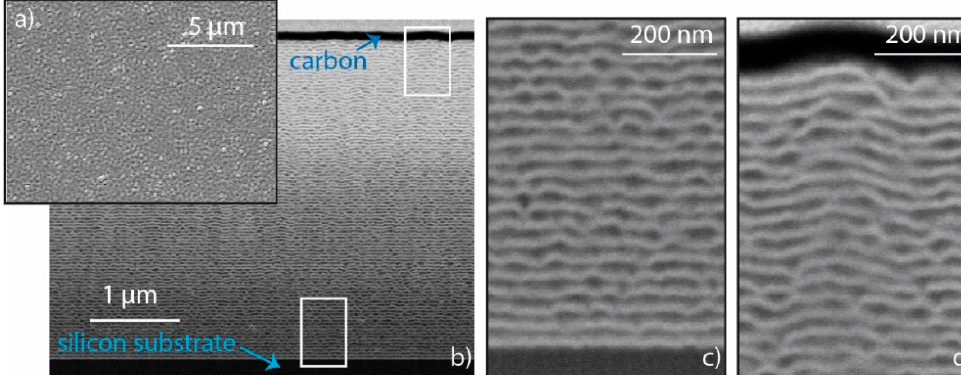
Figure 2. Scanning electron microscopy pictures of the planar Ni/Al multilayers: ( a ) Secondary electron image of the surface of the planar multilayer thin film from the top view. The material contrast images in ( b – d ) display the multilayer thin film in a tilted view of a FIB cross section (angle of tilt: 36 ◦ ) from different positions and varying magnification.